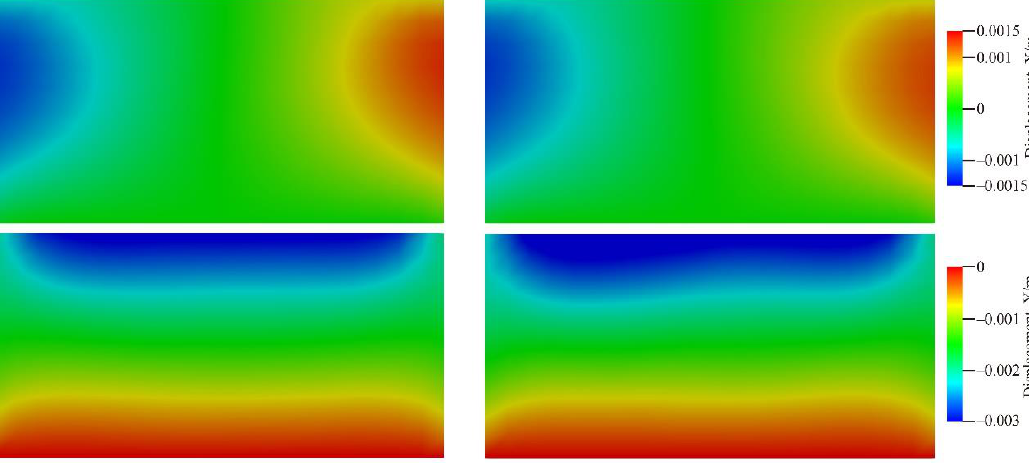
Figure 13. Horizontal ( a , b ) and vertical ( c , d ) displacements of two realisations when the coefficient of friction is 0.3.